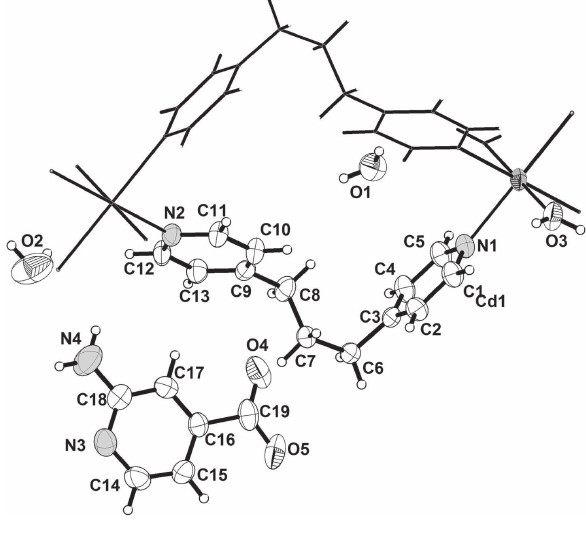
Table 1: Data collection and handling.